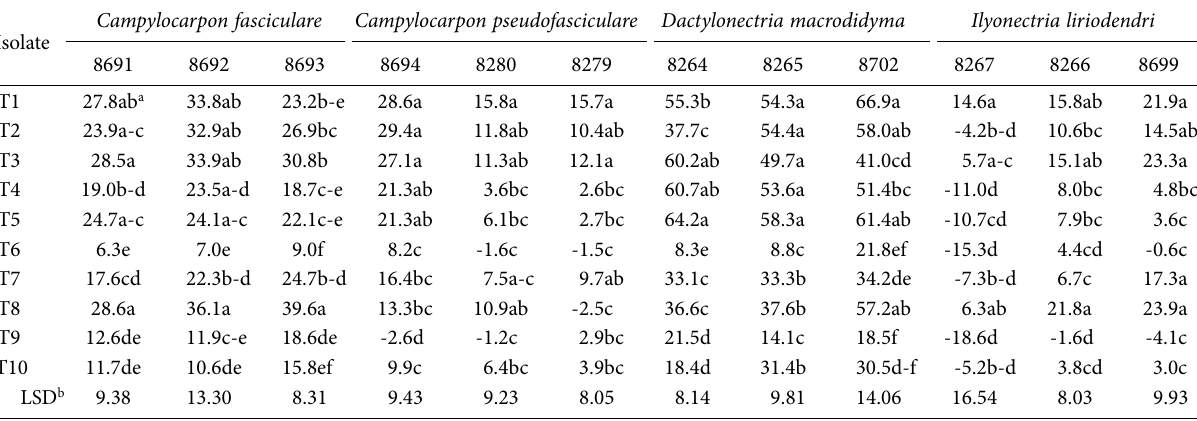
Table 2. Mean percentage of mycelium growth inhibition of four species of black foot disease pathogens (three isolates each) from volatile organic compounds (VOCs) produced by different Trichoderma spp. Isolates (T1 to T10).